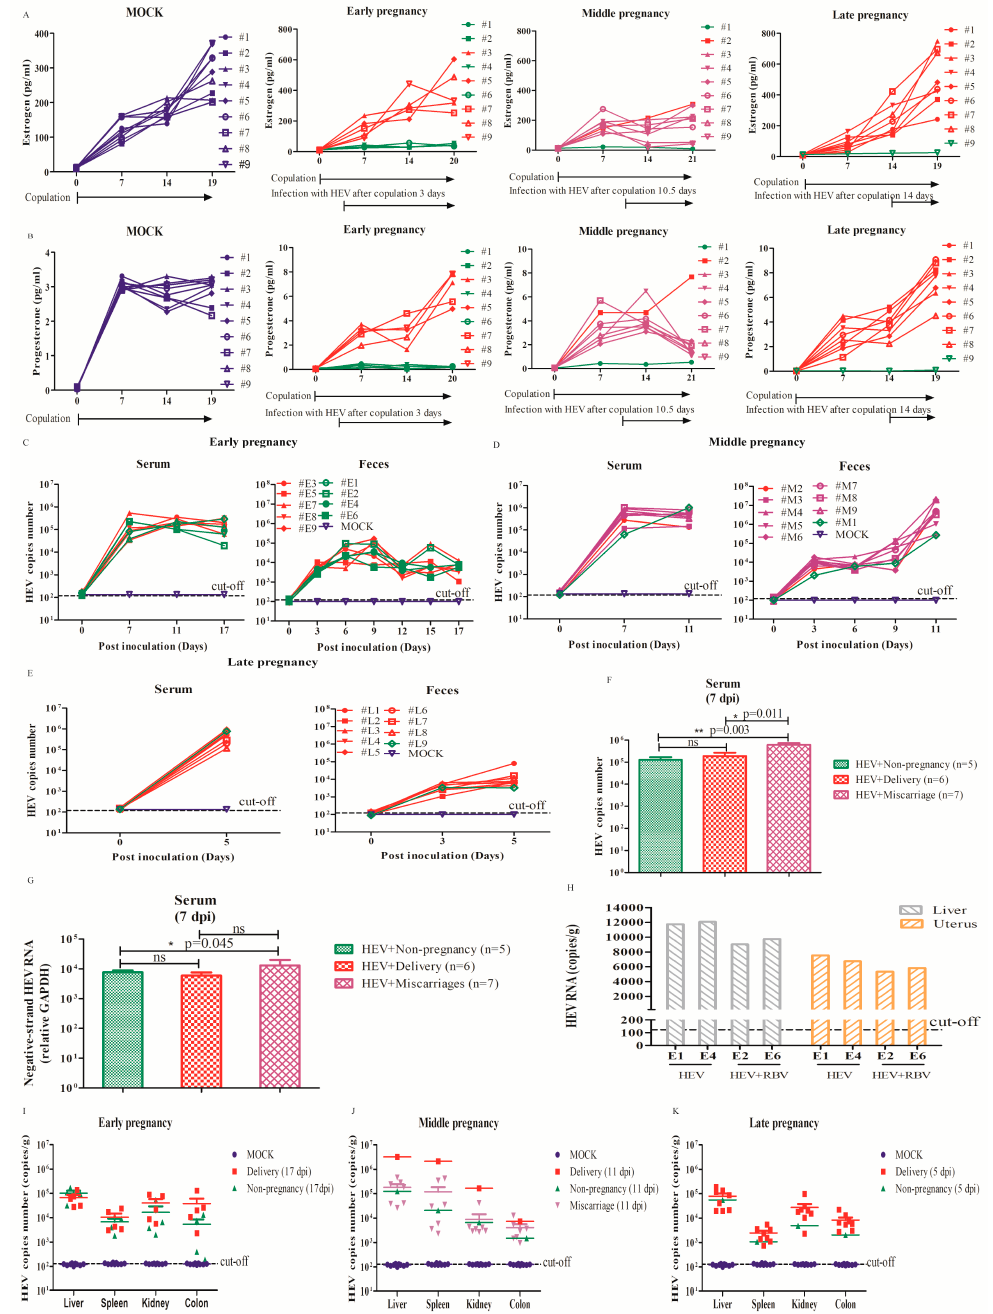
Figure 2. Profile of HEV infection in pregnant mice. The concentration of estrogen ( A ) and progesterone ( B ) in mice infected with or without HEV in the early, middle and late stages of pregnancy. The viral titer of HEV in the feces and serum of mice in early ( C ), middle ( D ) and late ( E ) pregnancy. ( F ) Comparison of the viral titer in serum among non-pregnant ( n = 5), delivery ( n = 6) and miscarriage ( n = 7) mice in early and middle pregnancy at 7 dpi. ( G ) The relative expression of negative-strand HEV RNA in the serum of HEV-infected non-pregnant ( n = 5), delivery ( n = 6) and miscarriage ( n = 7) mice in early and middle pregnancy at 7 dpi. ( H ) The viral titer of HEV in liver and uterus in HEV-infected non-pregnant mice in early pregnancy treated with or without or RBV. ( I–K ) The viral titer of HEV in the tissues of mice in early ( I ), middle ( J ) and late ( K ) pregnancy. Mock mice are drawn in a blue colour, non-pregnant mice are drawn in a green colour, delivery mice are drawn in a red colour, and miscarriage mice are drawn in a purple